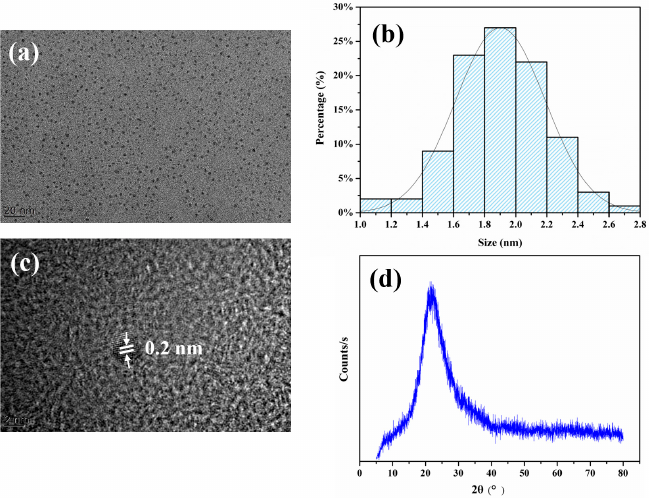
Figure 2. ( a ) TEM image of FA-PDA FONs. ( b ) Average size of FA-PDA FONs by intensity. ( c ) HRTEM image of FA-PDA FONs. ( d ) XRD pattern of FA-PDA FONs.